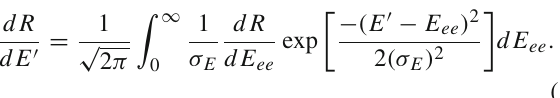
Table 2 Modulating [1] and upper limits on constant [11] DAMA